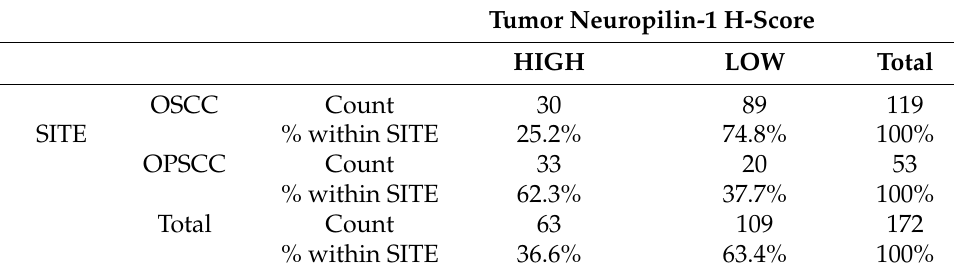
Table 4. The crosstabulation of tumor site by tumor Neuropilin-1 H-score groups